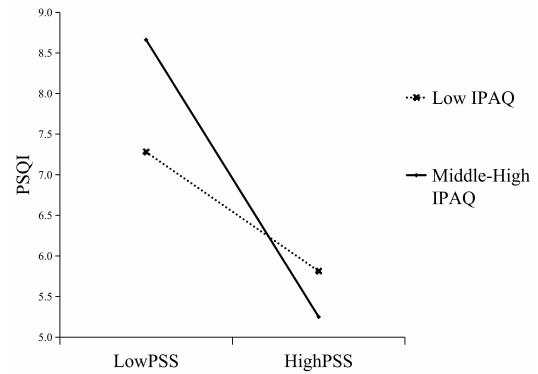
Fig. 2. Moderating role of IPAQ on the relationship between perceived social support and sleep